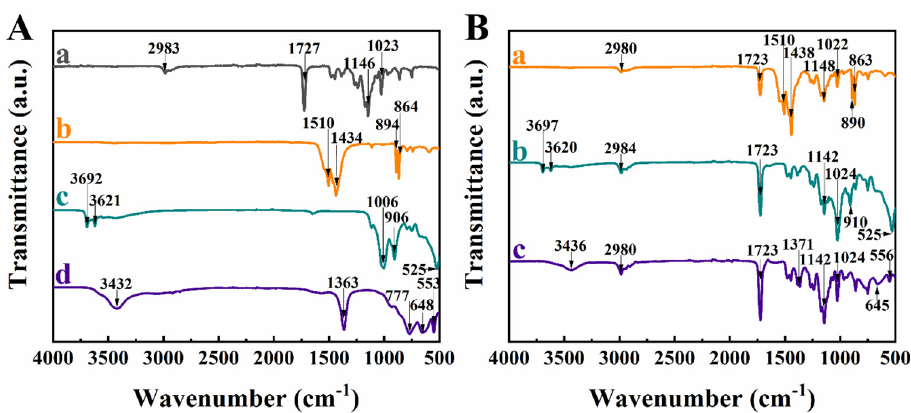
Figure 4. FTIR spectra of ( A ) as-received materials, namely, (a) PEMA, (b) huntite, (c) halloysite, and (d) hydrotalcite, and ( B ) as-deposited composite coatings, namely, (a) PEMA-huntite, (b) PEMA-halloysite, and (c) PEMA-hydrotalcite.